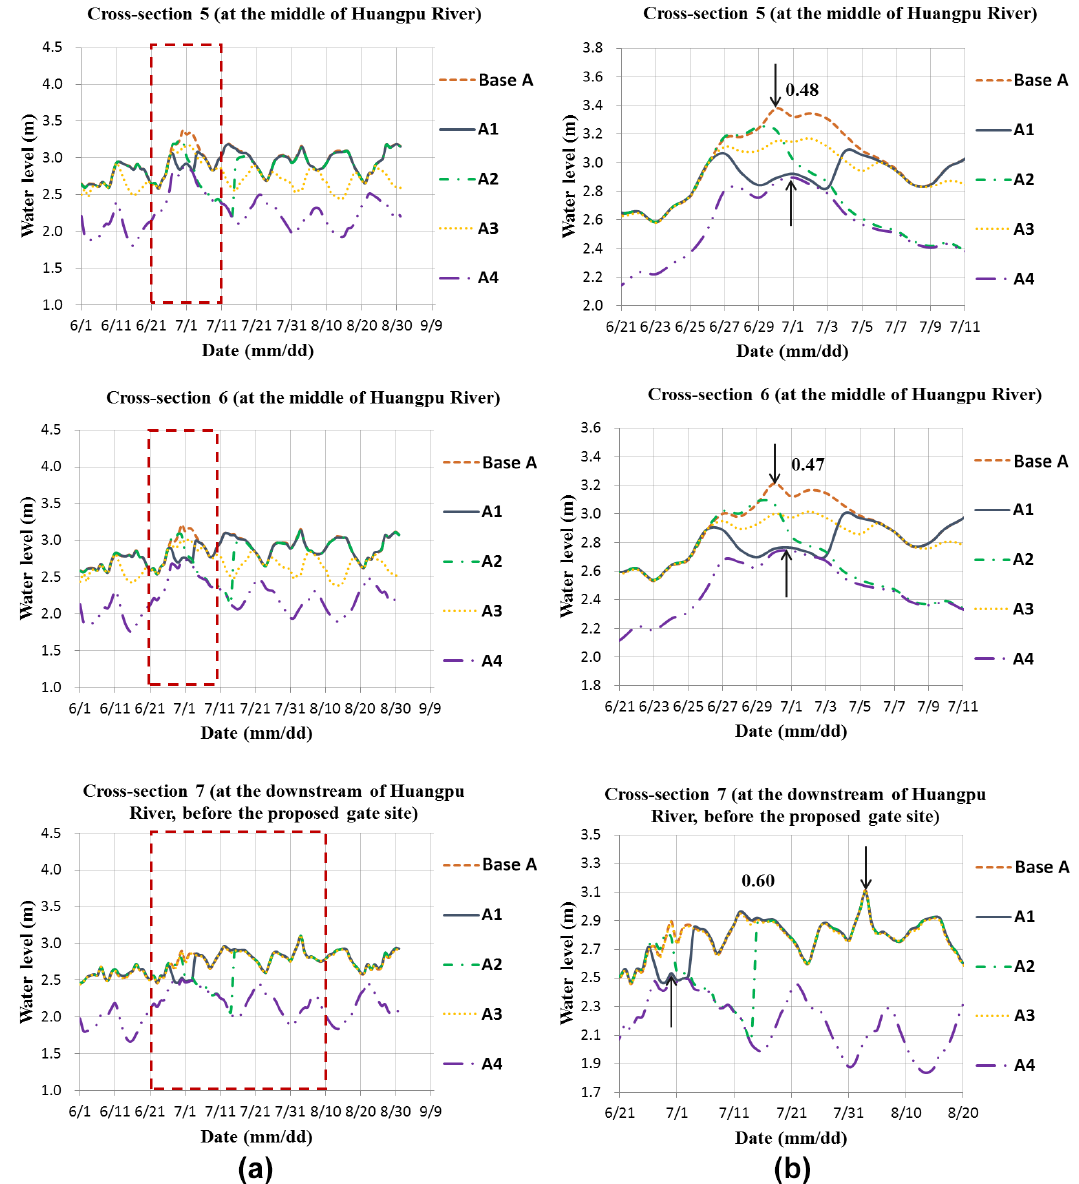
Figure 10. Comparison of the simulated water levels during the period from June to August in 1999 at the seven cross-section points (as shown in Fig. 1) along the Taipu Canal and Huangpu River under the five scenarios considered in this study (the figures on the right-hand side – b – are the zoom-in plots of the figures on the left-hand side – a